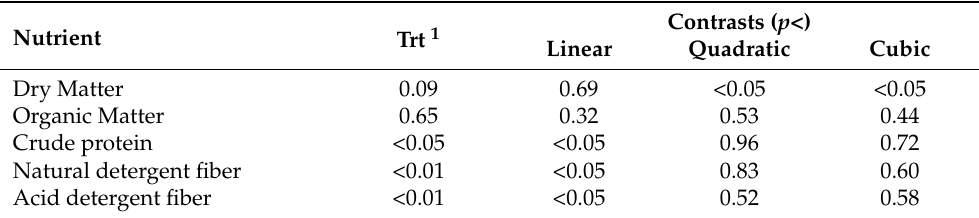
Table 4. Statistical significance of perceived nutritional digestibility and ruminal states in sheep given dry grape by-products-based diets